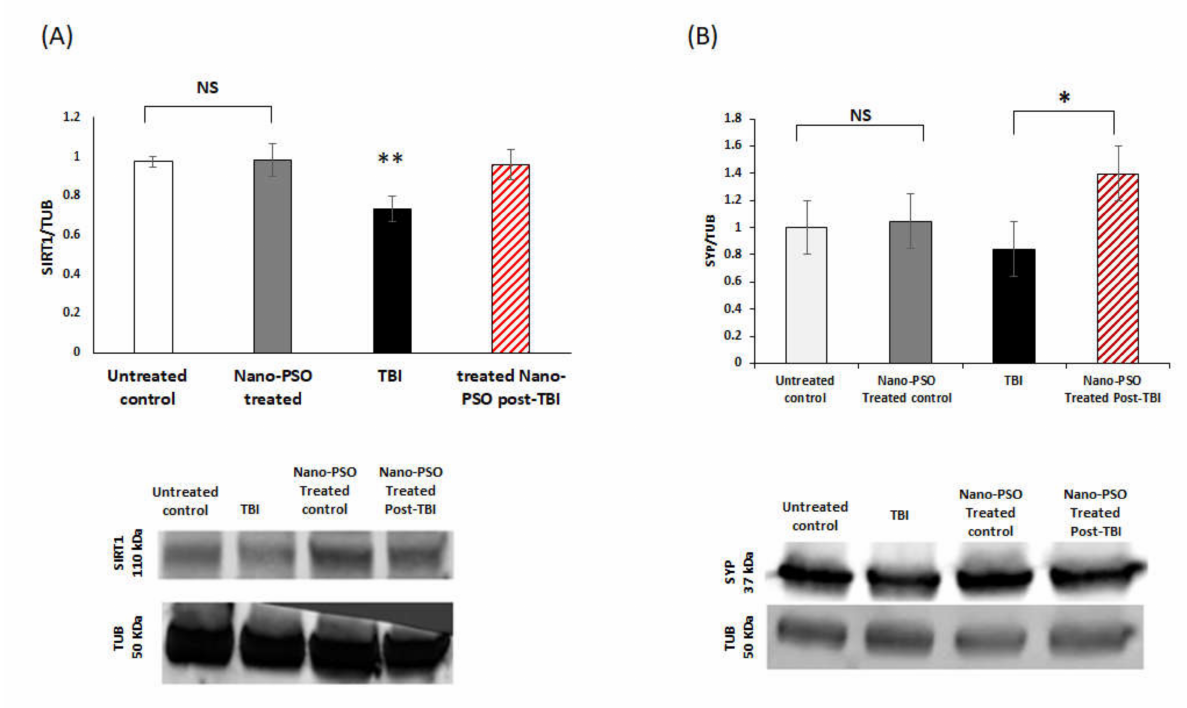
Figure 7. The impact of Nano-PSO on SIRT1/SYP expression in the cortex of TBI mice: ( A ) Brain homogenates from the right cortex of treated and untreated controls, as well as from TBI and Nano- PSO treated post-TBI mice were immunoblotted with SIRT1 and TUB detected at (110 KDa, 50 KDa), respectively. Quantitative analysis of immunoreactive bands of SIRT1 were quantified by Image J and normalized against the control protein TUB. Levels of SIRT1 were significantly reduced 30 days postinjury in the cortex of TBI mice compared to the control. Nano-PSO treatment prevented this reduction ** p < 0.01. One-way ANOVA revealed a significant elevation in the expression of SIRT1 in mice that received the treatment postinjury. (F (3, 20) = 1.084, p = 0.002, N = 5 Fisher’s LSD post hoc). ( B ) Brain homogenates from the right cortex of treated and untreated controls, as well as from TBI and Nano-PSO treated post-TBI mice were immunoblotted with SYP and TUB detected at (37 KDa, 50 KDa), respectively. Quantitative analysis of immunoreactive bands of SYP were quantified by Image J and normalized against the control protein TUB. One-way ANOVA revealed a significant elevation in expression of SYP in mice that received the treatment post-TBI compared to the TBI group (F (3,20) = 1.084, p = 0.379, Fisher’s LSD post hoc * p < 0.5, n = 4–5). NS = Not significant. Values are presented as mean ±